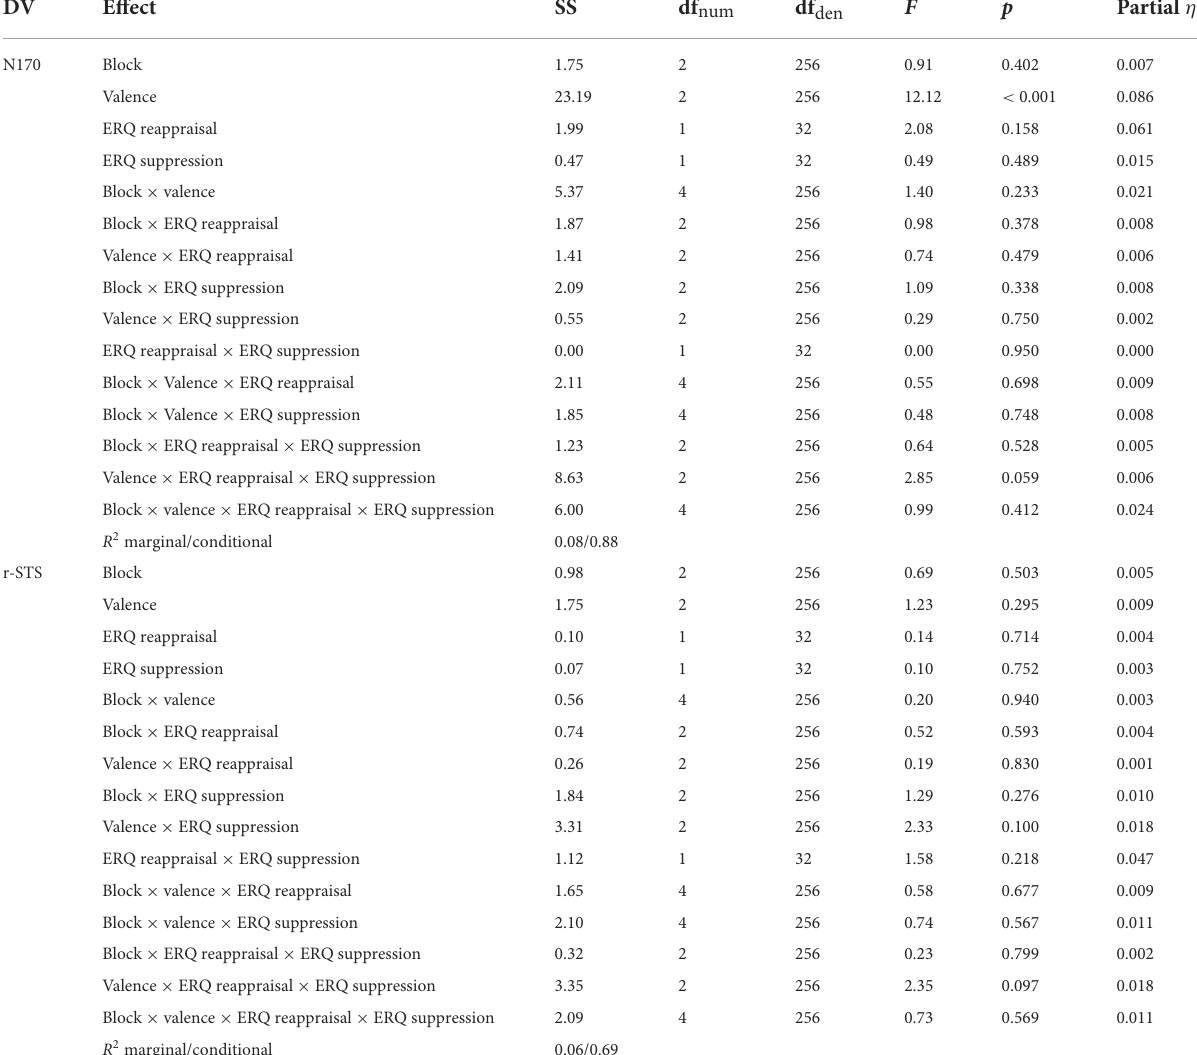
TABLE 1 ANOVA table of models in the prediction generation stage.